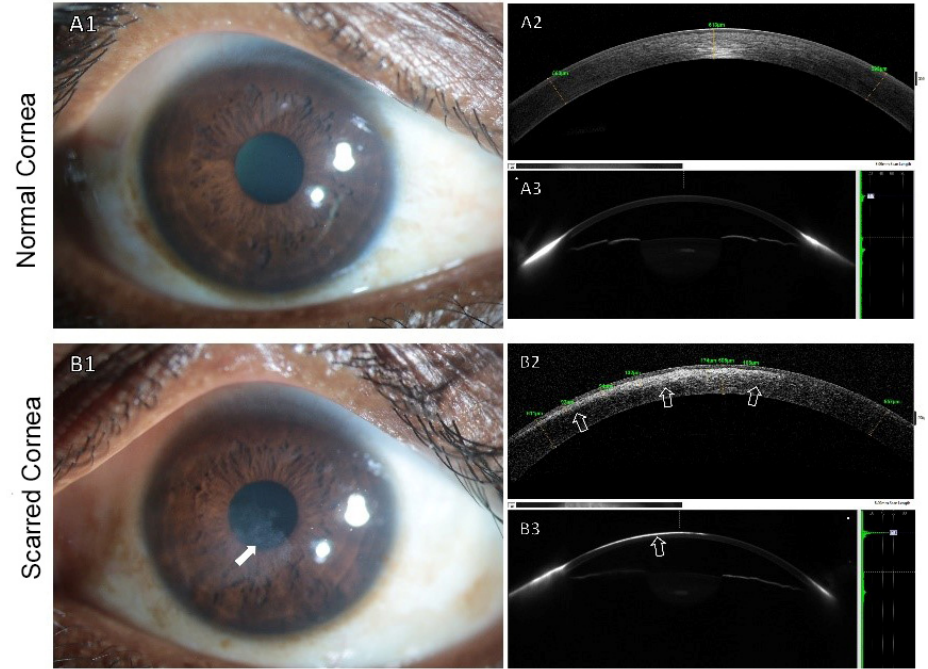
Figure 8. Clinical images of normal and scarred corneas (LVPEI Eye Hospital, Hyderabad, Telangana, India). Clinical appearance of a typical clear cornea and corneal scarring. Slit-lamp photography image ( A1 ), optical coherence tomography (OCT) image ( A2 ), and Scheimpflug image ( A3 ) of the right eye of a patient with a clear cornea. The corresponding images of the left eye with corneal scarring show opacification and haziness on slit-lamp biomicroscopy (white arrow, B1 ). Increased reflectivity in the anterior stroma with thinning and irregularity on OCT imaging (white outlined arrows, B2 ). Increased light scattering on Scheimpflug scanning (white outlined arrow, B3 ).